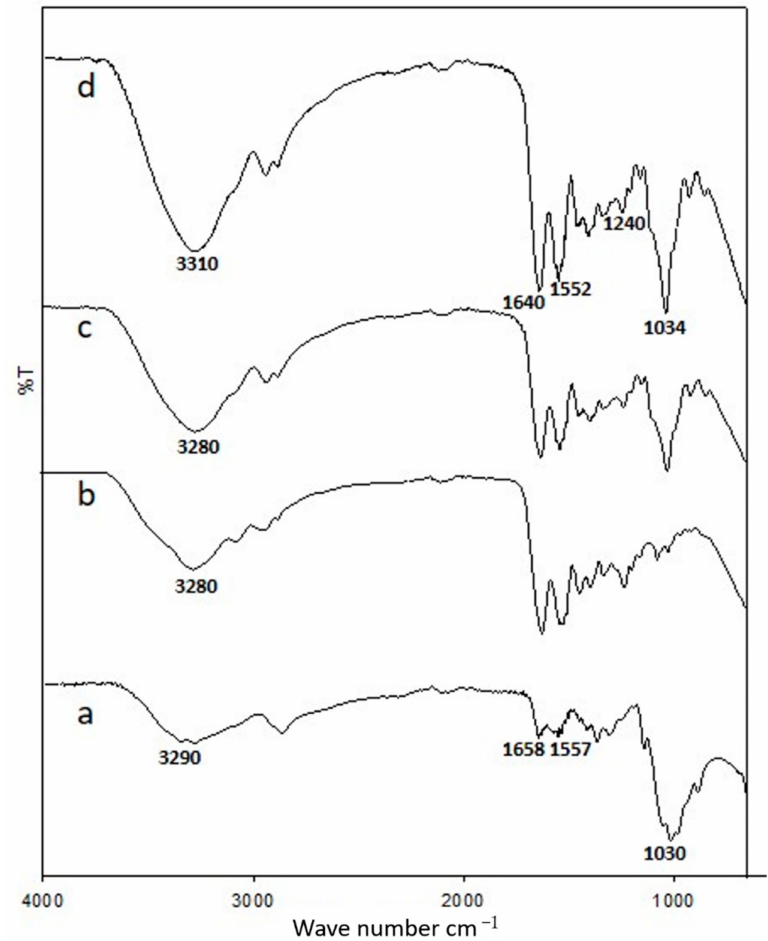
Figure 1. Attenuated total reflectance (ATR) spectra of ( a ) chitosan membrane, ( b ) gelatin membrane, ( c ) 1:7 chitosan–gelatin membrane (without crosslinking), and ( d ) 1:7 genipin-crosslinked chitosan– gelatin